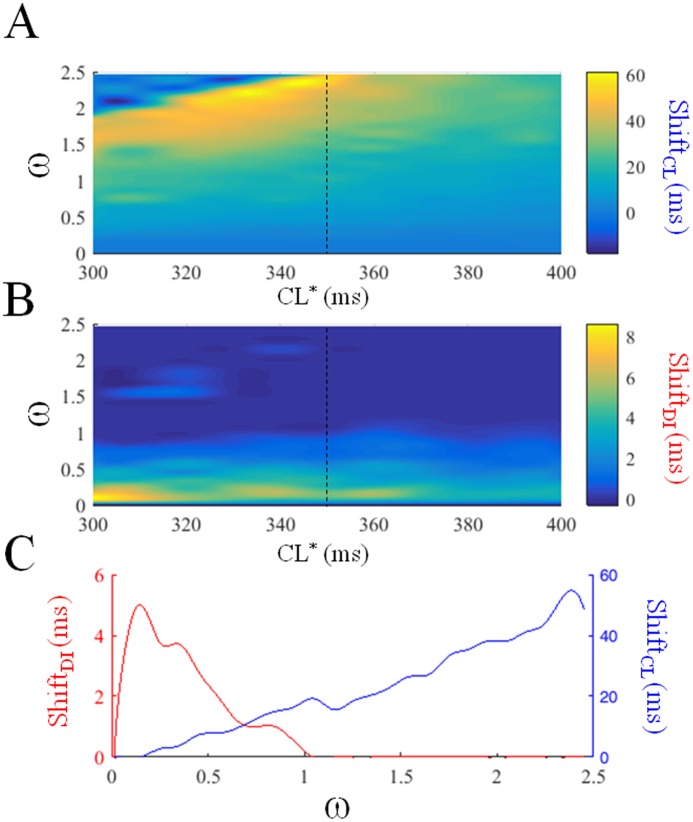
ShiftCL and ShiftDI.dERCL and dERDI were measured as in Fig 4 under periodic pacing for ɷ varying from 0.1 to 2.5 step 0.05 and for CL* varying from 300 ms to 400 ms step 10 ms, and shown in the top and middle panels respectively; the value of ShiftCL (A) and ShiftDI (B) are shown along the z-axis in color code (note the different scales). Panel C shows ShiftCL and ShiftDI versus ɷ for CL* = 350 ms (vertical broken line in color panels). The lack of smoothness in ShiftCL and ShiftDI along the ɷ and CL* directions is due to the numerical resolution of the corresponding simulations described above.